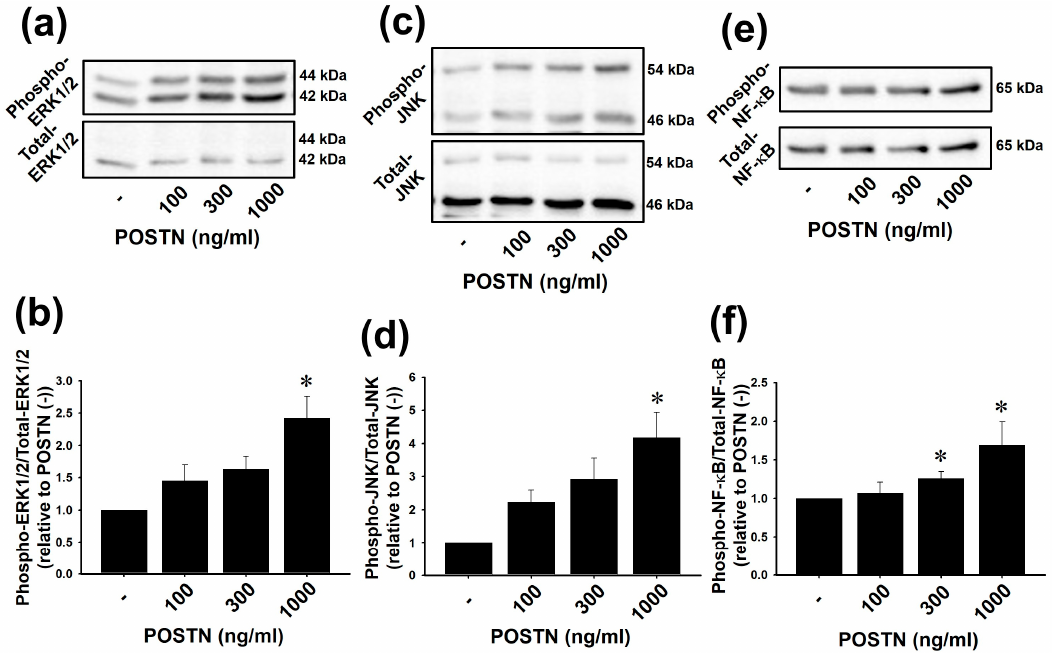
Figure 3. Recombinant rat POSTN activated ERK1/2, JNK and NF- κ B in RVFbs isolated from RVs of non-treated normal rats. RVFbs were stimulated with recombinant rat POSTN (100–1000 ng/mL) or solvent (POSTN (-)) for 1 h. Phosphorylation of ERK1/2, JNK and NF- κ B in RVFbs was evaluated by western blotting. ( a , c , e ) Representative blots were shown. ( b , d , f ) Phosphorylation level of ERK1/2, JNK and NF- κ B was corrected by the total protein, and the normalized phosphorylation relative to POSTN (-) was shown as mean ± S.E.M. ( n = 3). * p < 0.05 versus POSTN (-).